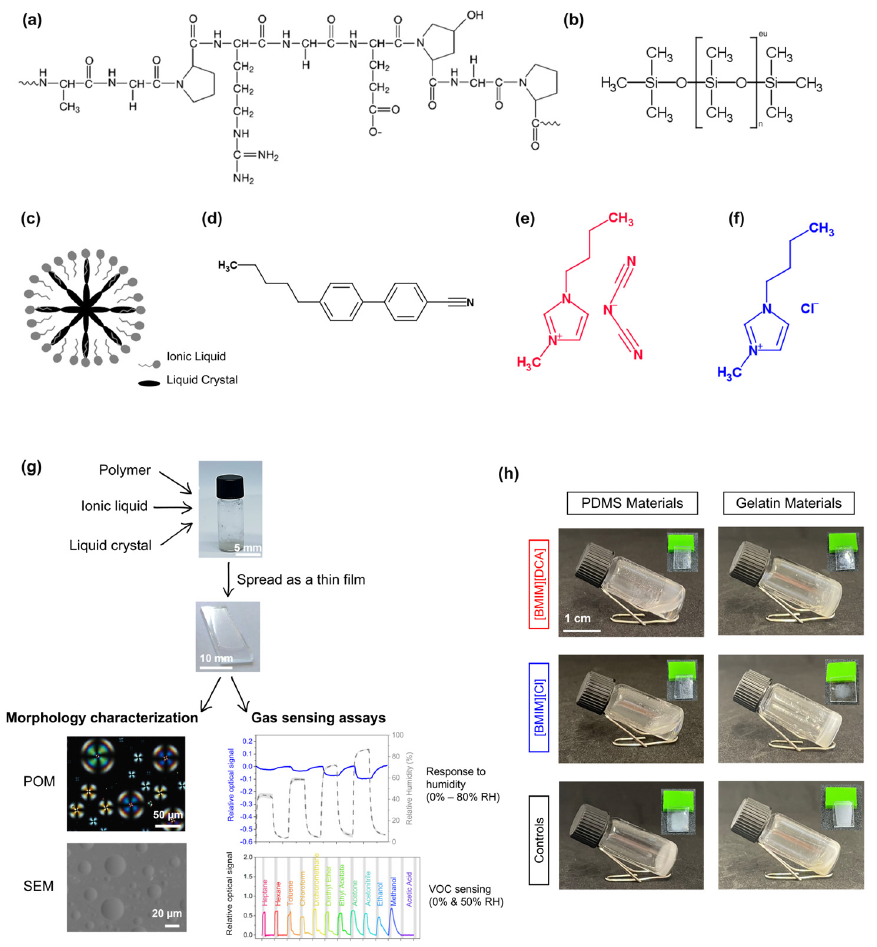
Figure 1. Hybrid gels production and characterization. ( a ) Gelatin and ( b ) PDMS chemical structures. ( c ) Schematic representation of an ionic liquid-liquid crystal-droplet. ( d ) Chemical structure of the liquid crystal 5CB and of ( e ) [BMIM][DCA] and ( f ) [BMIM][Cl] ionic liquids. ( g ) Schematic representation of the method followed for hybrid gels production and characterization. The images are representative of the characterization and sensing assays further detailed in the text. ( h ) Macroscopic appearance of the hybrid gel formulations; the inset photo shows the films produced with each formulation and used as gas